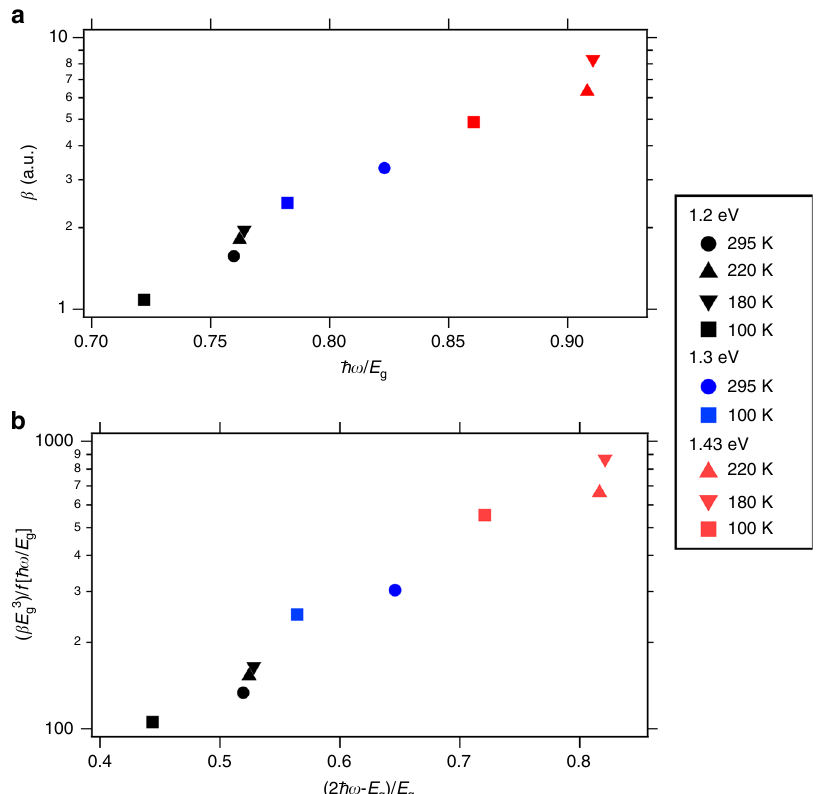
Fig. 3 Bandgap dependence of 2PA coef fi cient β . a β of CH 3 NH 3 PbI 3 obtained using temperature-dependent TRMC at different photon energies and temperatures. The values of β calculated from the temperature-dependent TRMC measurements are expressed in arbitrary units due to the near infrared sensitivity of the temperature-dependent TRMC cell. However, this does not affect the trend for β . b Scaled 2PA coef fi cient β versus normalized photon energies with respect to the material band gaps at different temperatures. Scaling has been performed according to the empirical scaling law (expression (22) of ref. 24 ). Legend denotes the excitation energy and temperature for each data point. All corresponding data are summarized in